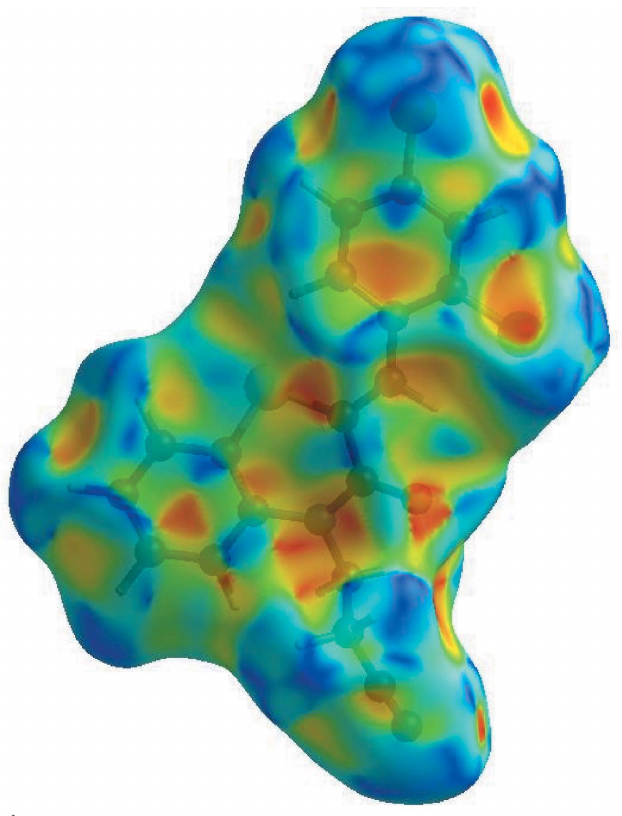
Figure 6 Hirshfeld surface of the title compound plotted over shape-index.